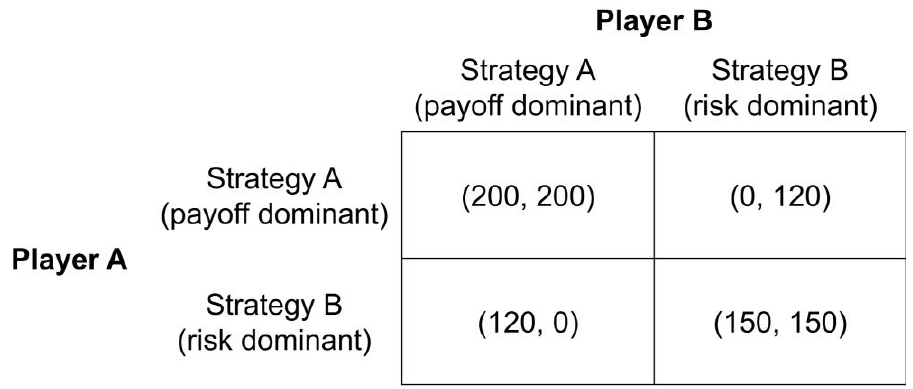
Figure 1. Payoff structure of the stag hunt game.